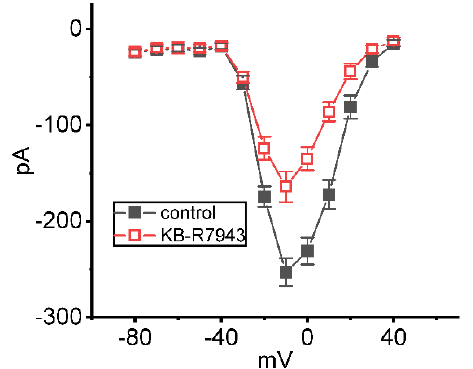
Figure 3. Effect of KB − R7943 on I Na(T) evoked by different levels of depolarizing voltage commands measured from GH 3 cells. Average current versus voltage ( I − V ) relationships of peak amplitude of I Na(T) under control (filled black squares) and during the exposure to 3 μM KB -R7943 (open red squares). Each cell was depolarized from − 80 mV to various potentials ranging from − 80 to +40 mV in 10 mV increments for a duration of 30 ms. The I Na(T) amplitude was measured at the beginning of each voltage pulse. Each point represents the mean ± SEM ( n = 7).